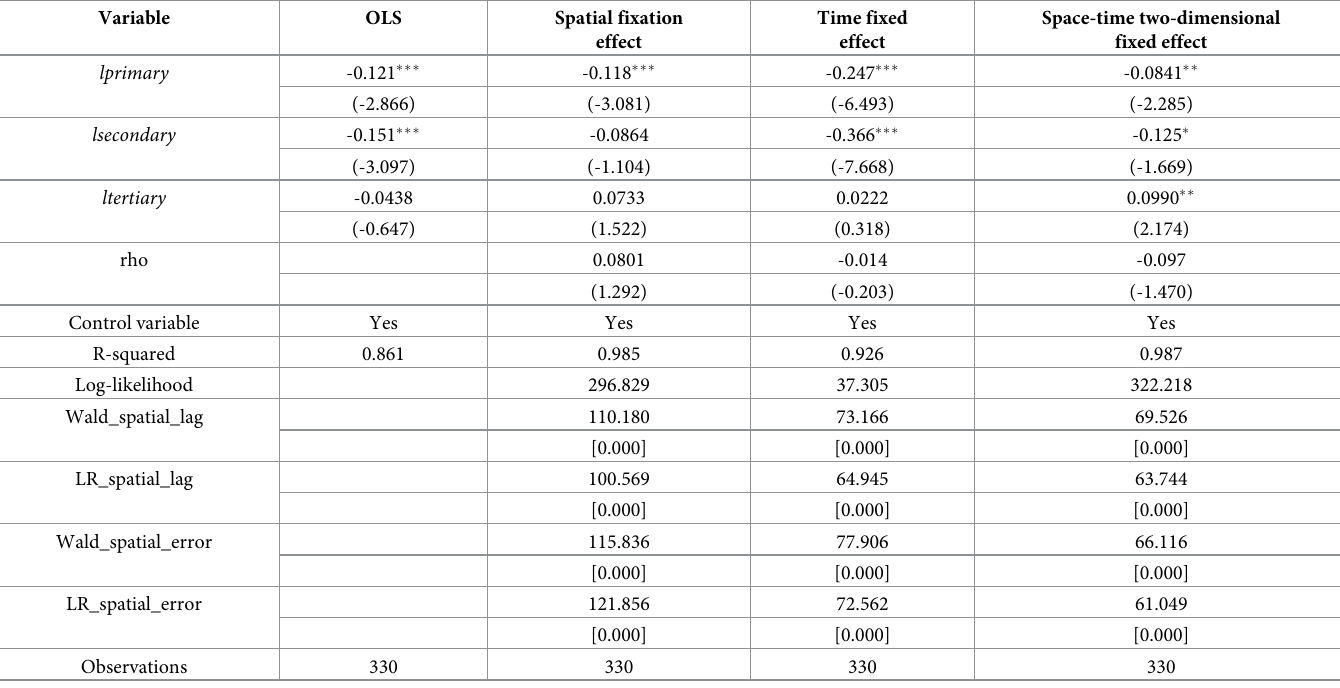
Table 5. Estimated results of the SDM for high-quality economic development.